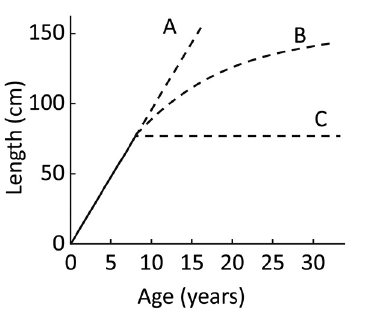
Fig. 1. – Representation of the “reproductive drain hypothesis”, i.e. the notion that reaching the size at first maturity relationship causes previously “linear” growth (line A) to decline due to “energy” previously used for somatic growth being transferred to the elaboration of gonads, with line B implying a small and line C a large transfer of “energy” (modified from Figure 2 in Lester et al. 2004).